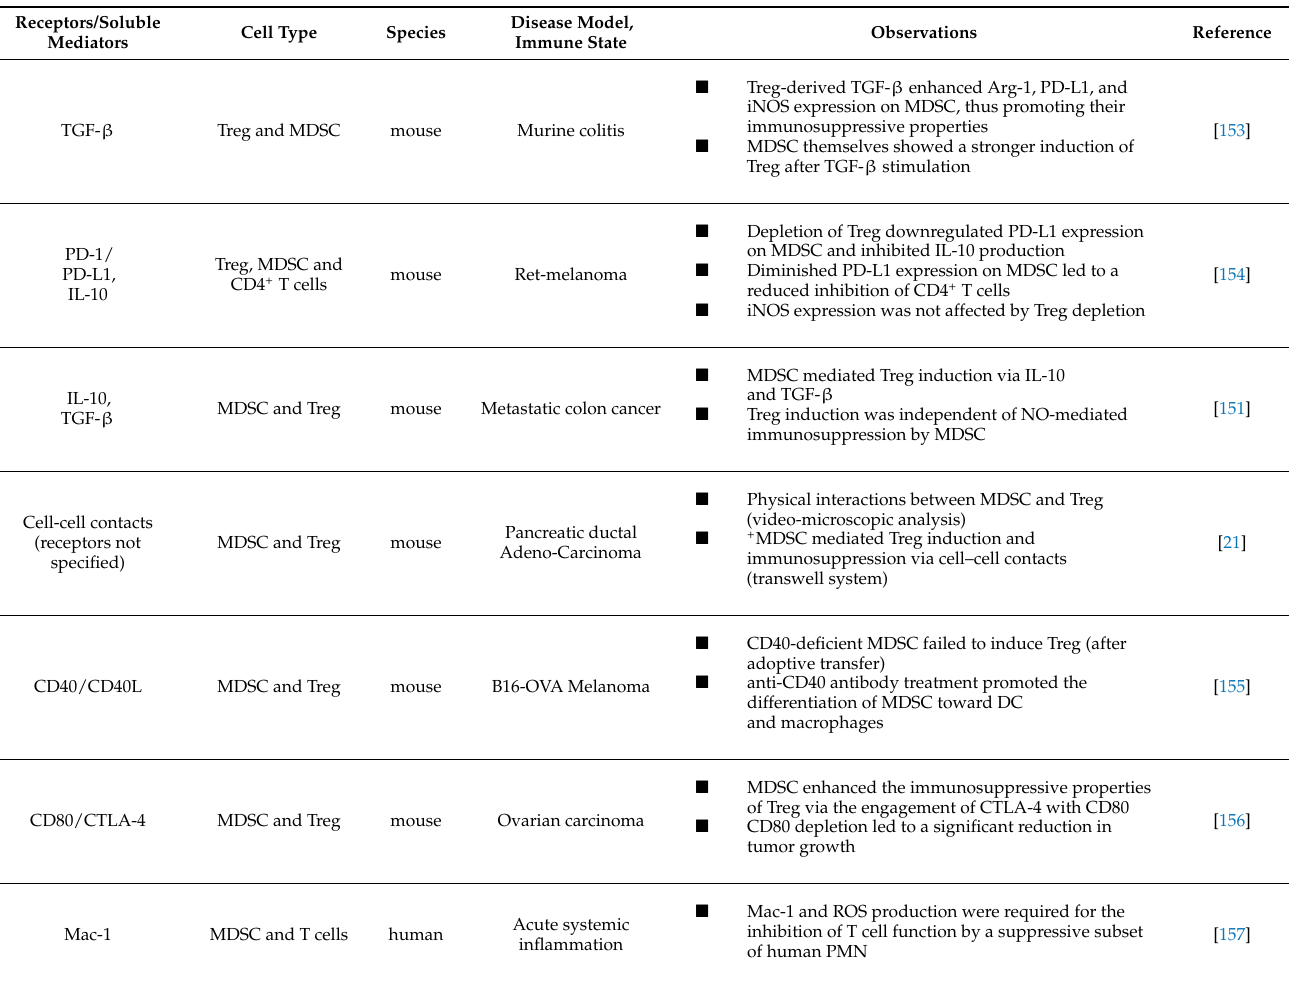
Table 2. A selection of important mediators in the functional crosstalk between MDSC and Treg. Receptors/Soluble